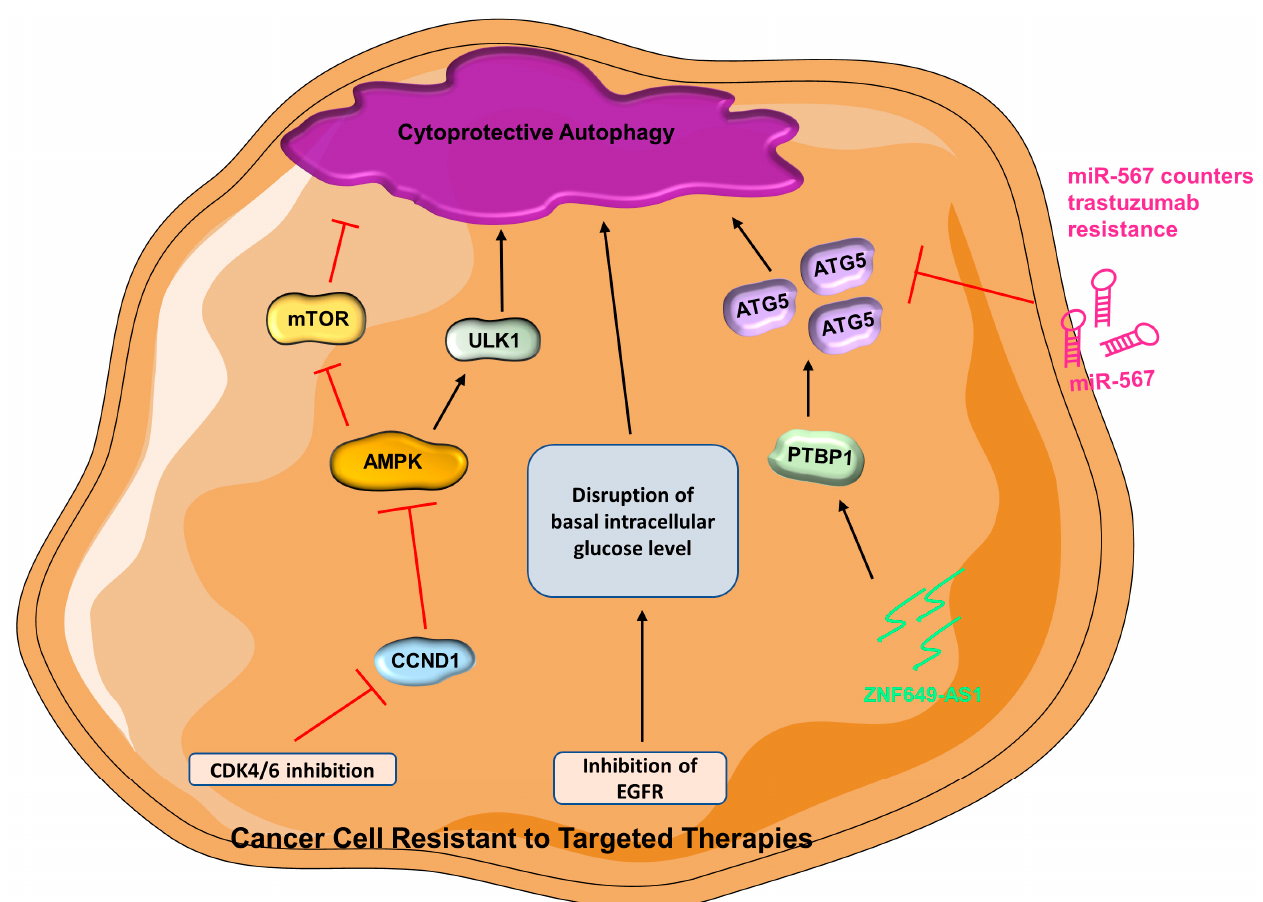
Figure 2. In cancer cells resistant to targeted therapies, cytoprotective autophagy is promoted (AMPK = AMP-activated protein kinase; ATG5 = autophagy-related gene-5; CCND1 = cyclin D1; CDK4/6 = cyclin-dependent kinase 4 and 6; EGFR = epidermal growth factor receptor; miR-567 = microRNA 567; mTOR = mammalian target of rapamycin; ULK1 = Unc-51 like autophagy activating kinase 1; PTBP1 = polypyrimidine tract binding protein 1; ZNF649-AS1 = ZNF649 Antisense RNA 1).